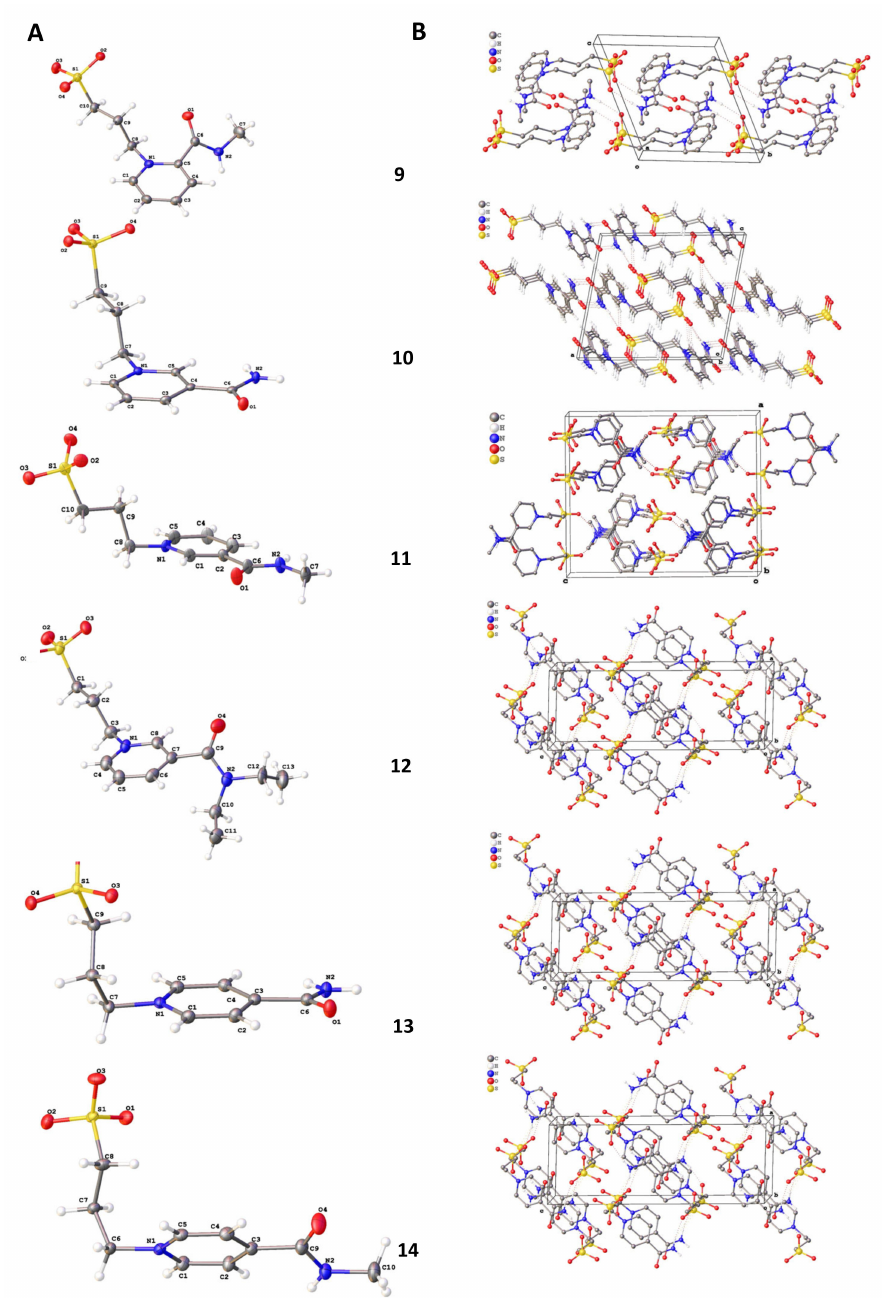
Figure 5. Molecular structures ( A ) and crystal packing ( B ) of 9–14 ellipsoids (probability of ellipsoids is equal to